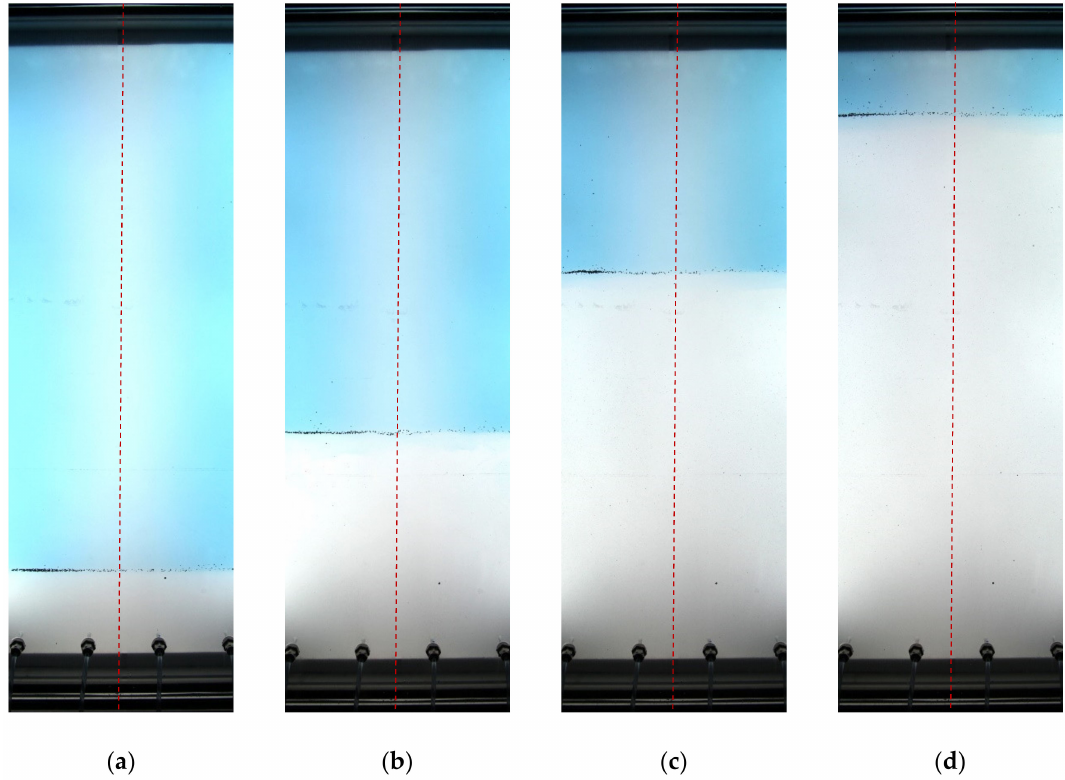
Figure 5. Snapshots of displacement flow in test no. 2: ( a ) t = 0 s; ( b ) t = 5 s; ( c ) t = 10 s; ( d ) t = 15